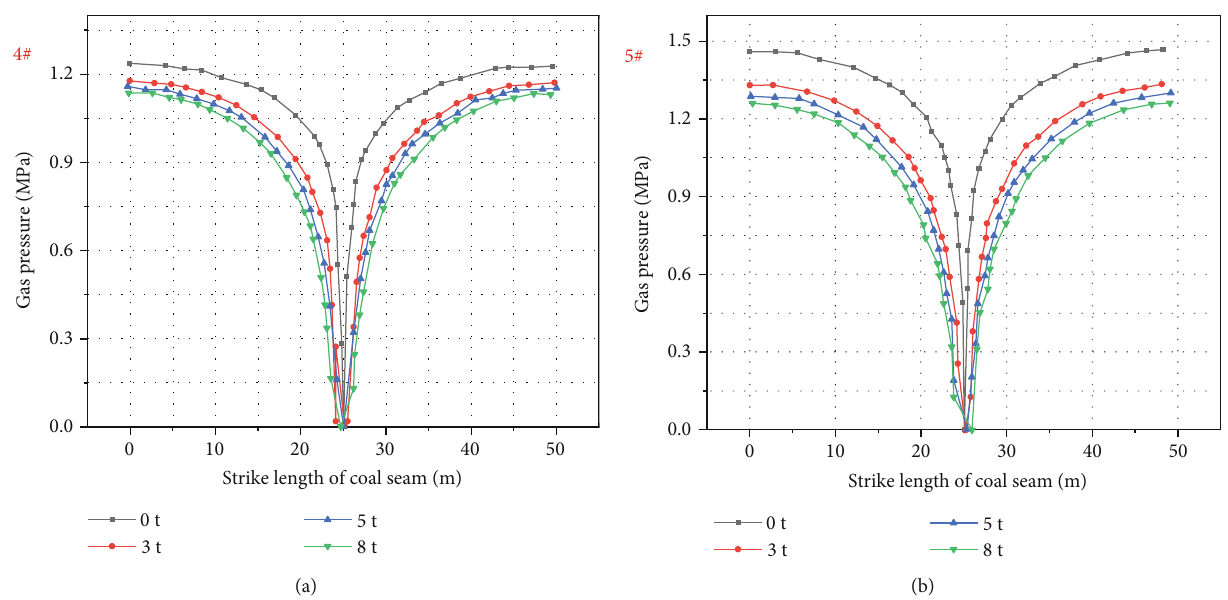
Figure 10: Variation of gas pressure at di ff erent coal output after 60 d of extraction.